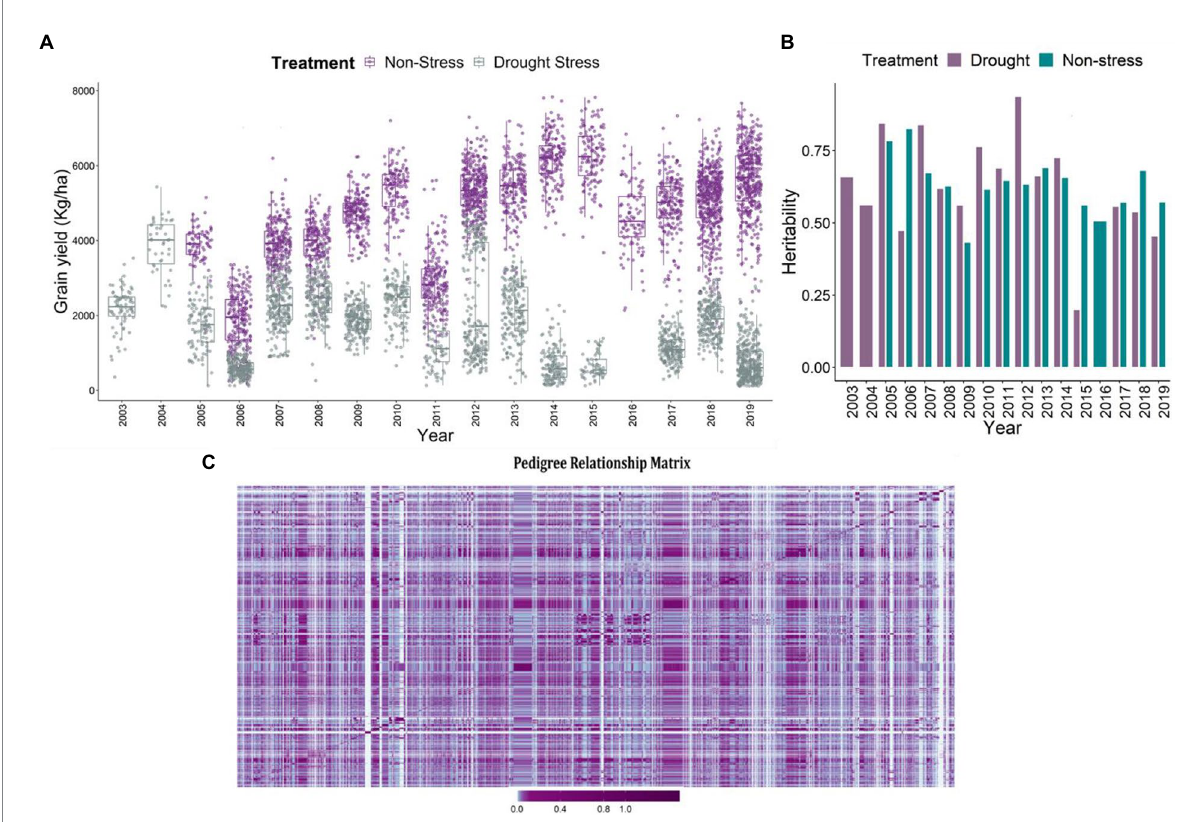
TABLE 1 The predictive abilities for the three selection criterion’s; CV2, CV1 and CV0 analyzed to predict grain yields under non-stress conditions with calibration sets viz., non-stress (NS) and Combined [All (stress and non-stress)] (CSN) datasets using seven models.